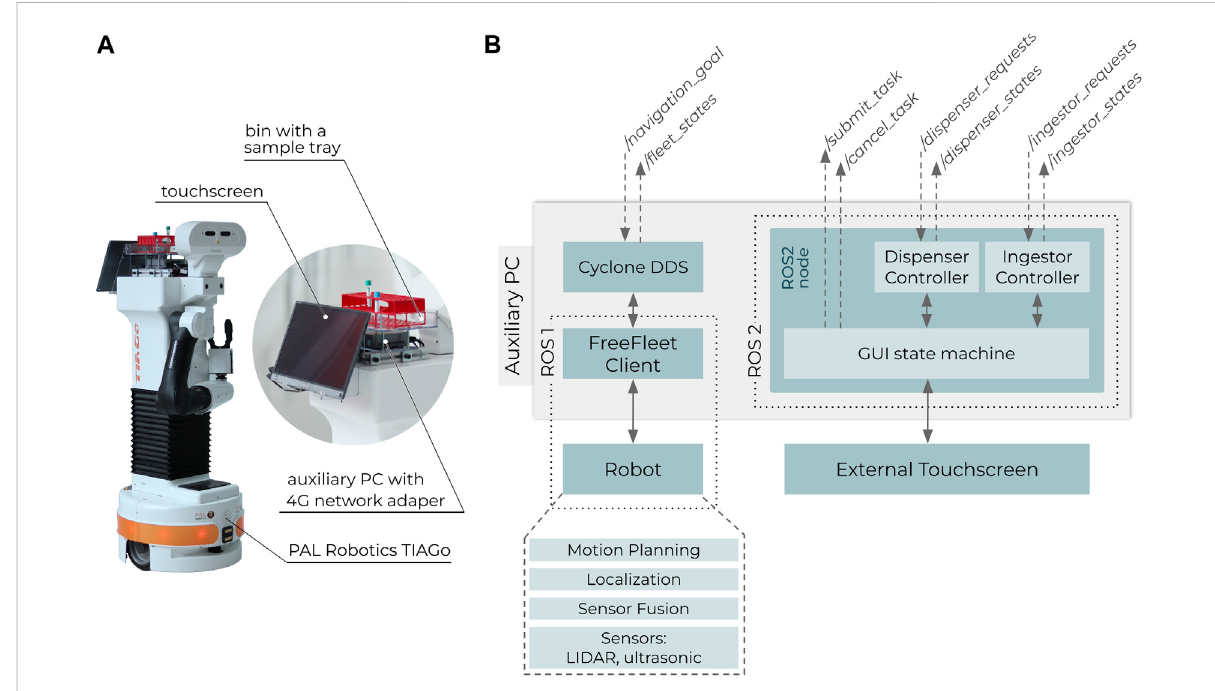
FIGURE 6 PAL Robotics TIAGo with additional hardware for the object transportation task (A) . Software setup of the whole robot (B) .